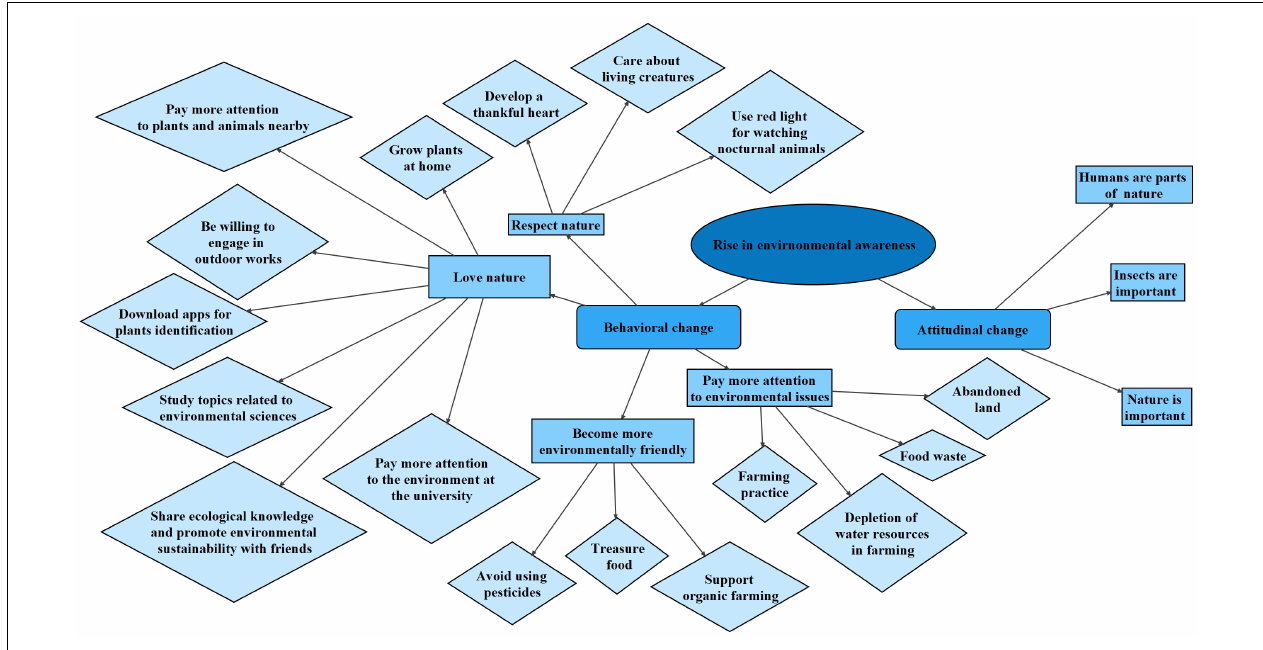
FIGURE 4 | Mapping of the codes within the theme ‘Rise in environmental awareness.’ Different shapes refer to different levels of themes.